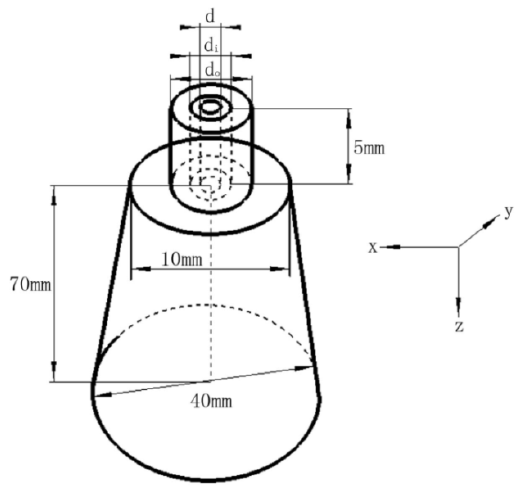
Figure 4. Computational domain.